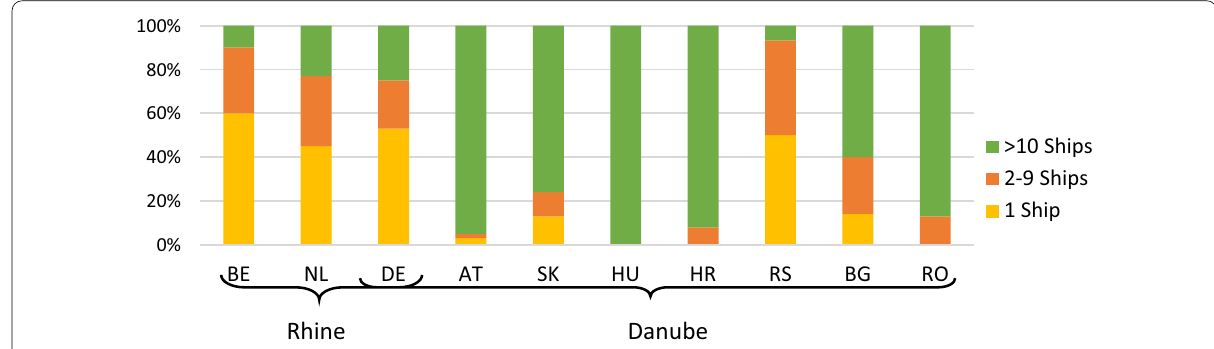
Fig. 4 Inland ship owners expressed by the number of ships owned. Source : authors adaptation of Eurostat [23] data, Maverick & STC-Nestra [34] and Serbian Ministry of Construction Transport and Infrastructure